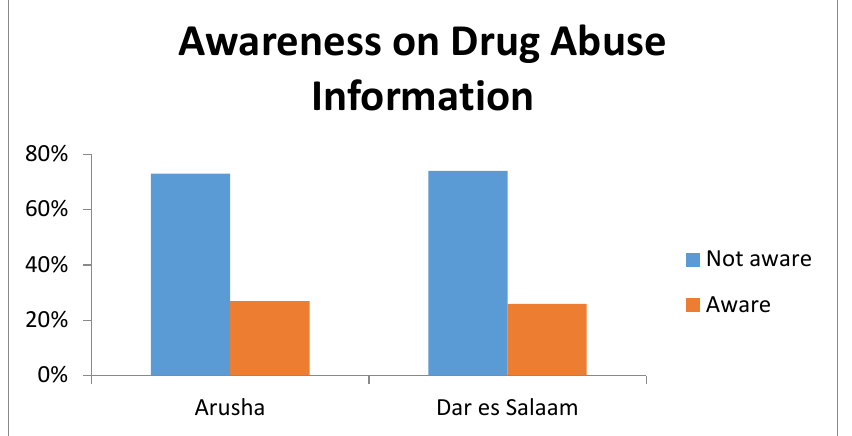
Figure 1. Awareness in Dar es Salaam and Arusha Awareness on the Treatment Location